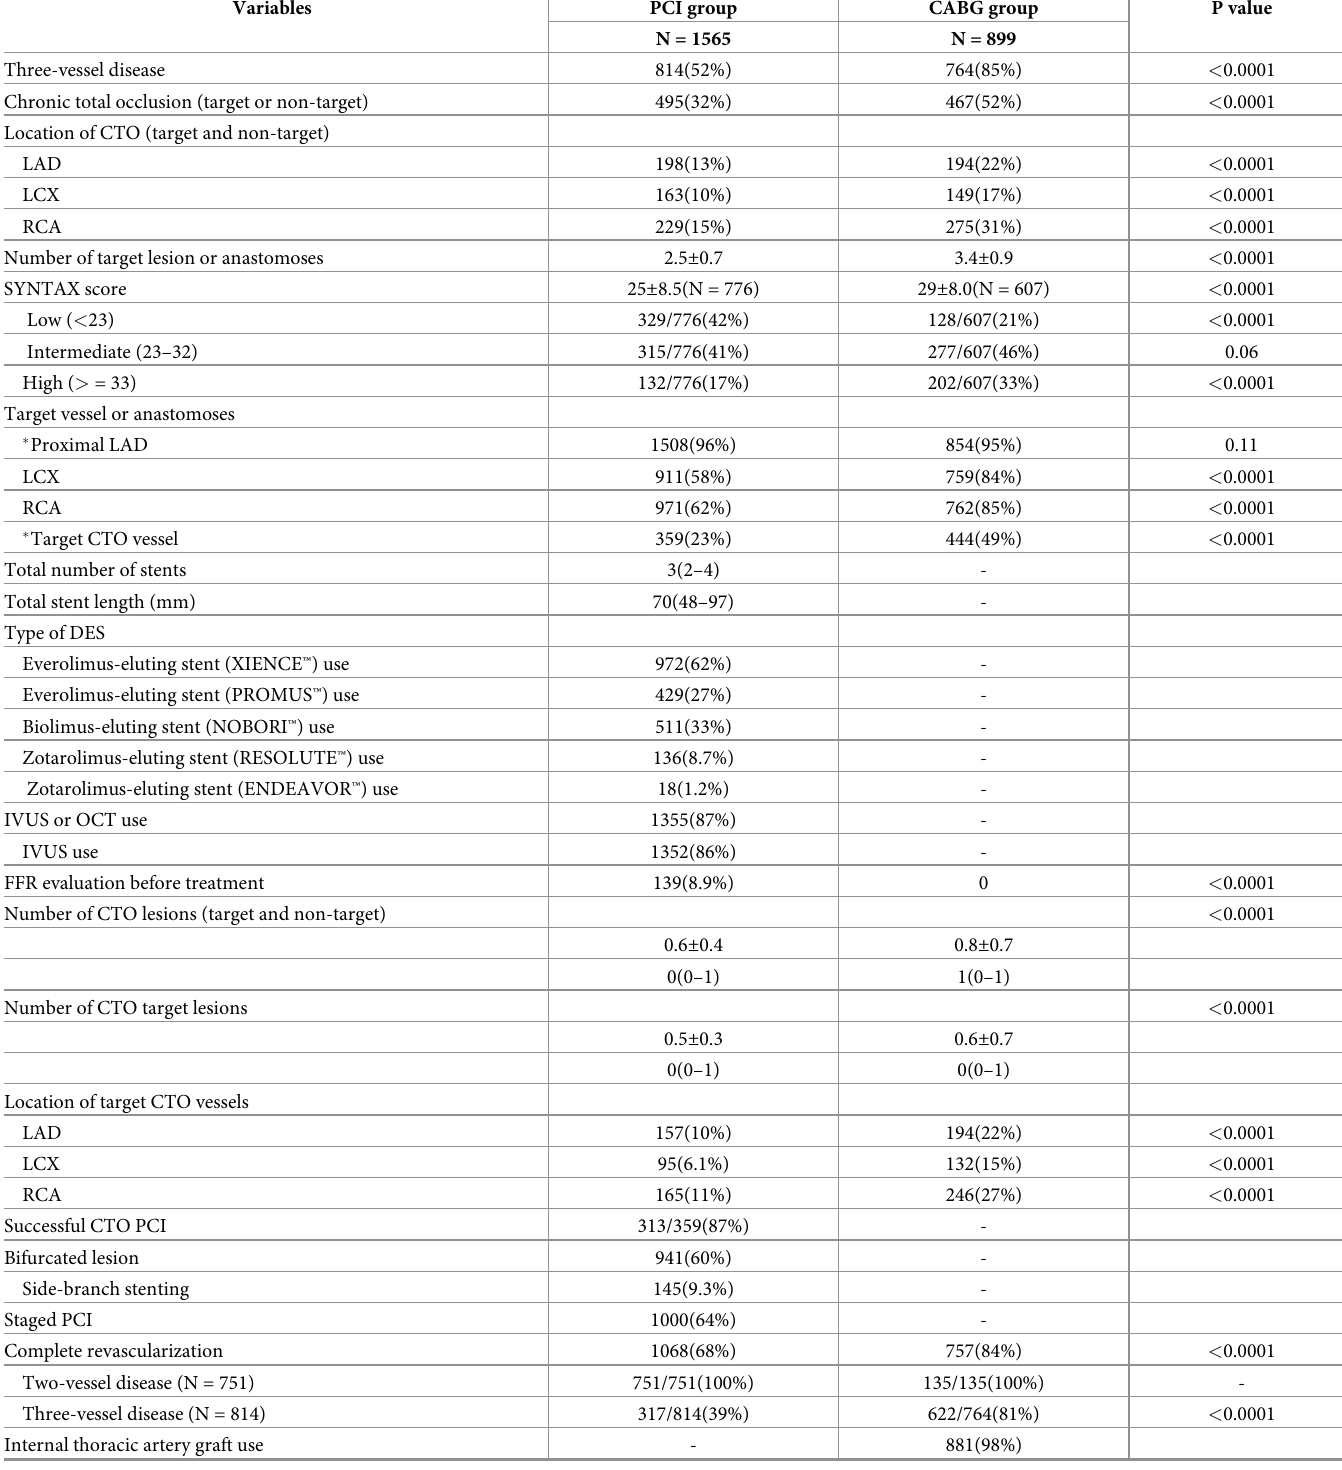
Table 2. Angiographic and procedural characteristics: PCI group versus CABG